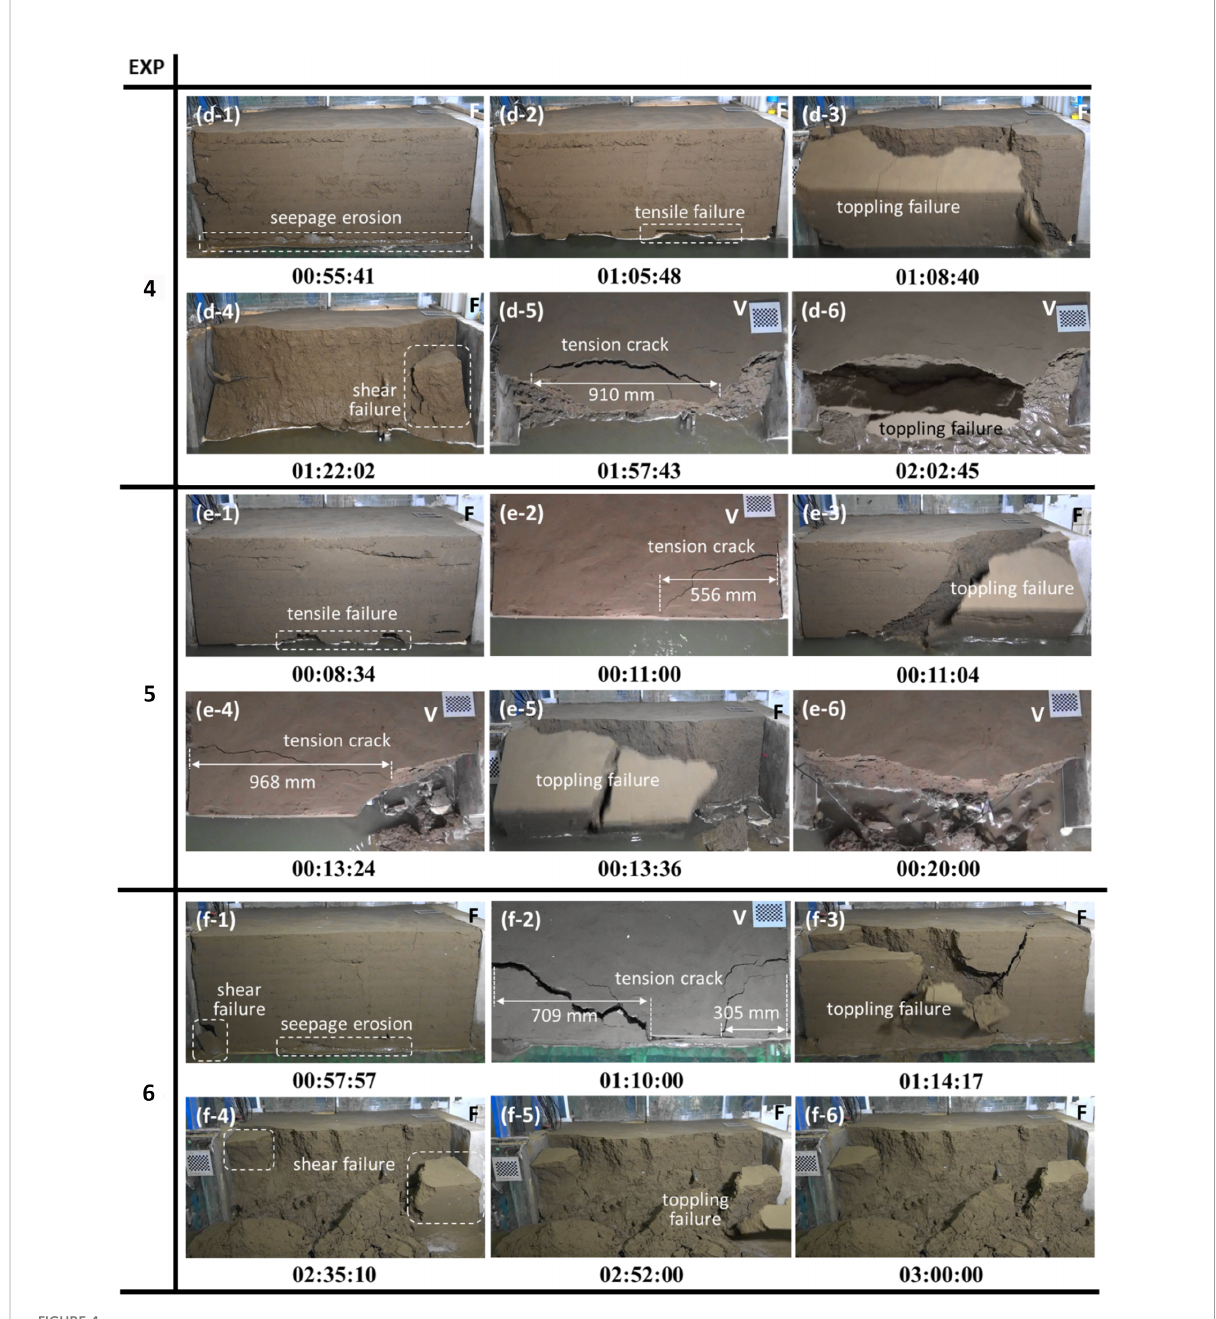
FIGURE 4 Photos of bank pro fi le evolution during each 3D experiment: (D) EXP 4: Hs = 60 cm, Ts = 1 h, Hw = 15 cm, Tw = 1 h; (E) EXP 5: Hw = 15 cm, Tw = 1 h; (F) EXP 6: Hs = 60 cm, Ts = 3 h. F, front view; V, vertical